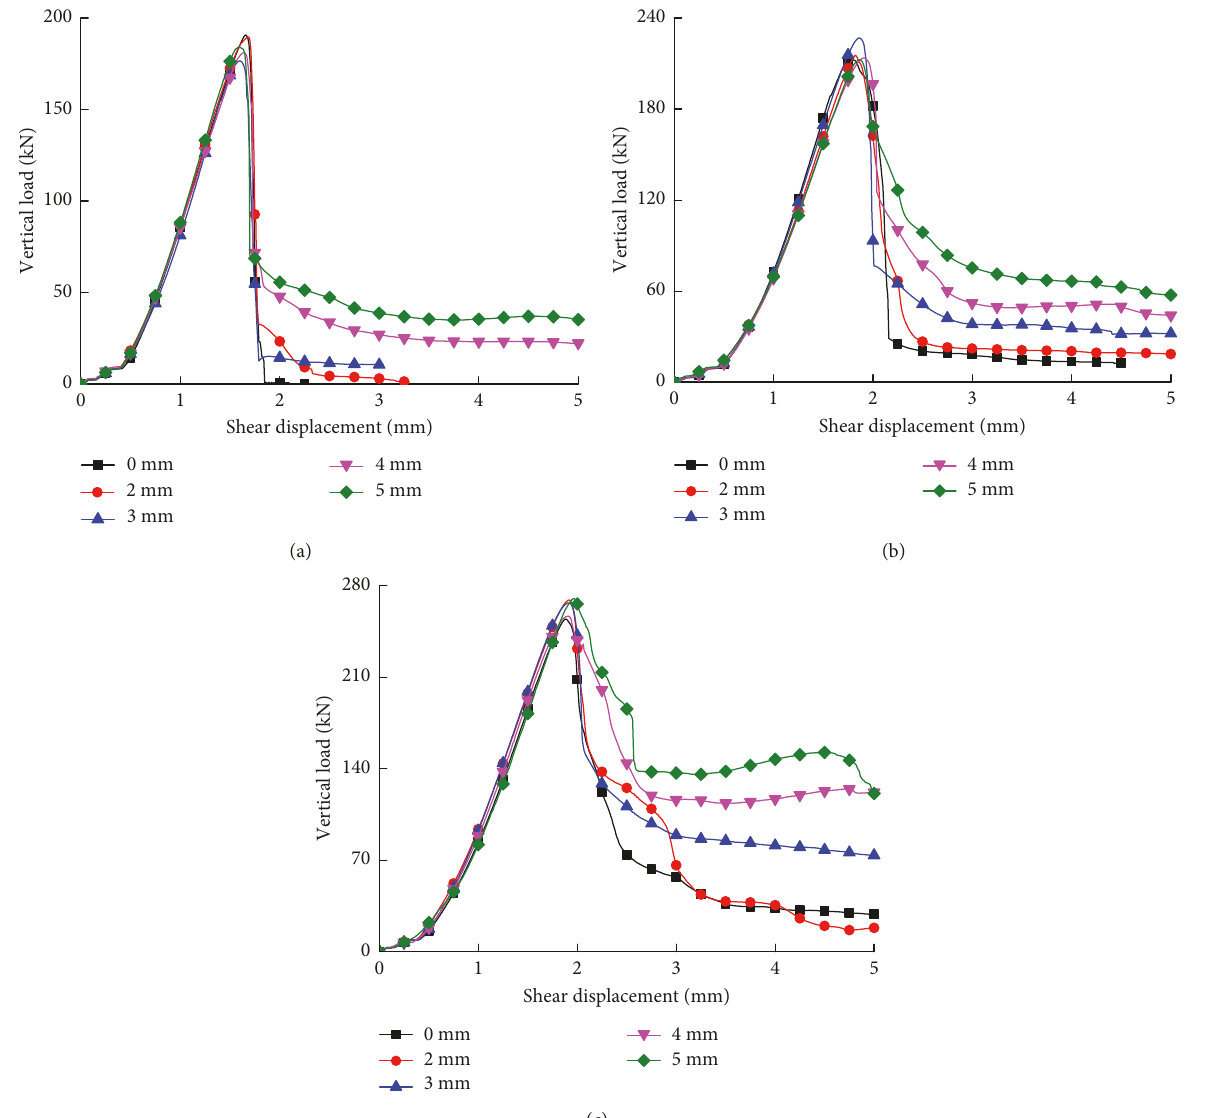
Figure 7: Shear strength profile of bolted concrete blocks with different slope angles of the shear plane ranging from 63 ° to 53 ° . (a) c � 63 ° ; (b) c � 58 ° ; (c) c � 53 °